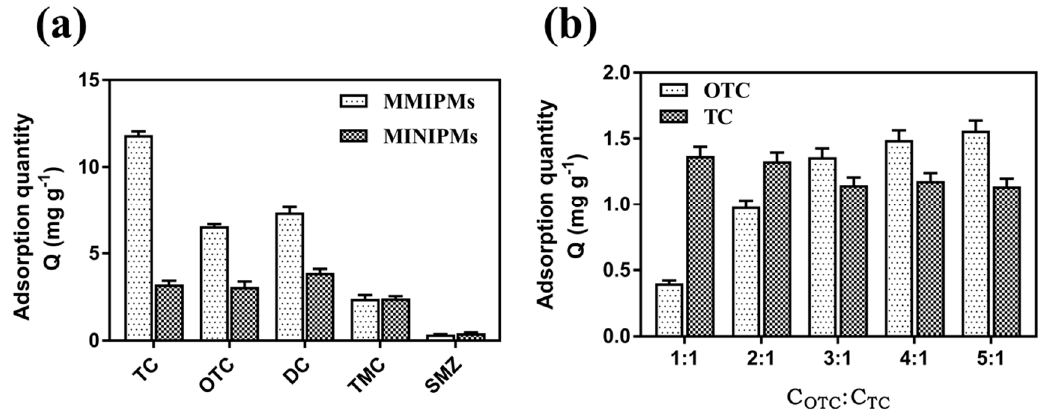
Figure 8. Adsorption capacity of MMIPMs and MINIPMs towards TCs ( a ). The competitive adsorption of MMIPMs toward OTC and TC ( b ).